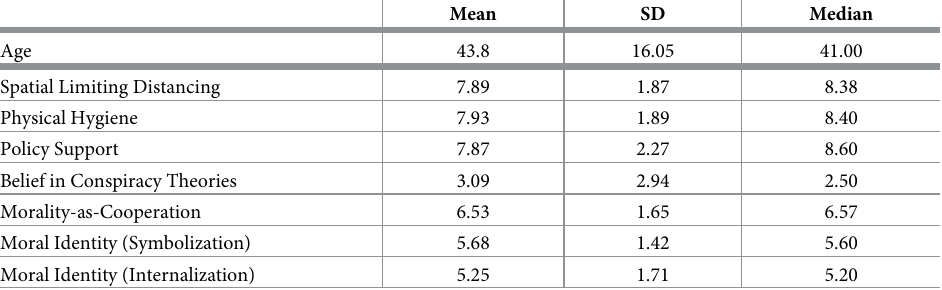
Table 1. Summary